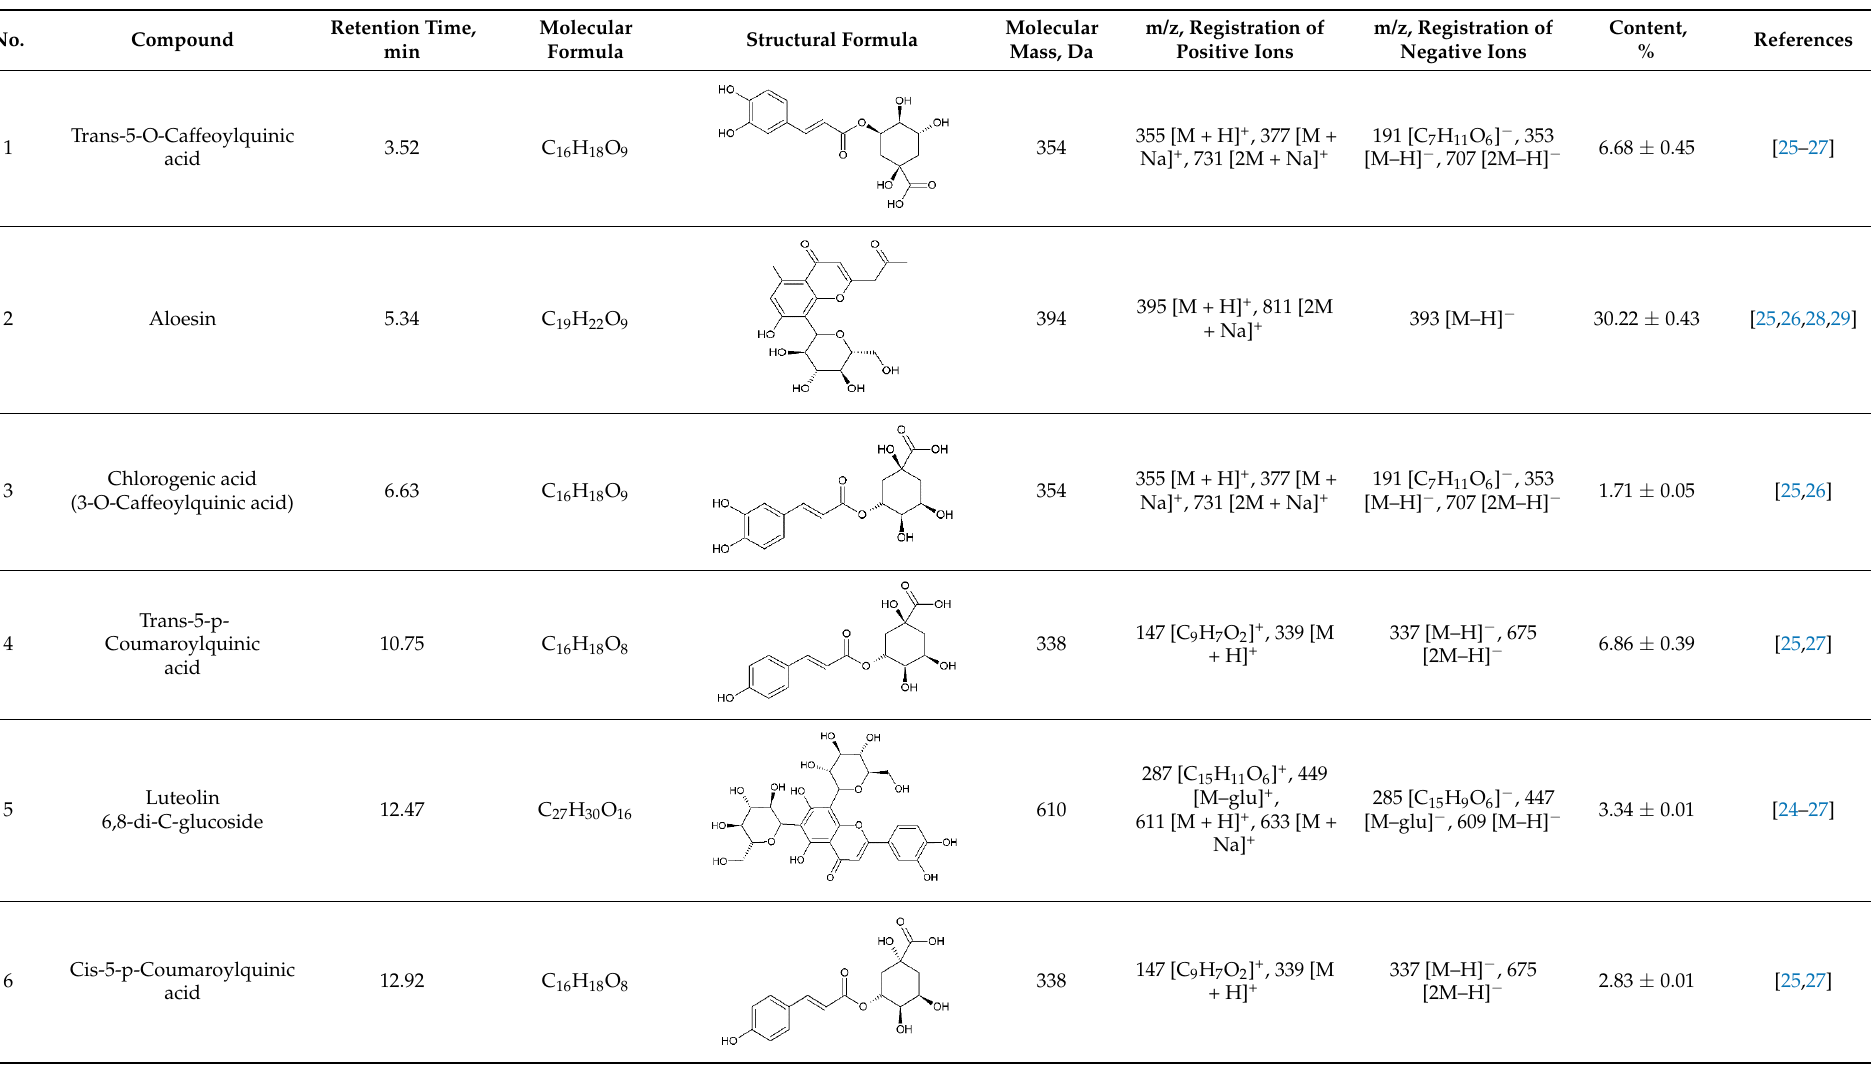
Table 1. Phytochemical composition of Aloe vera extract.